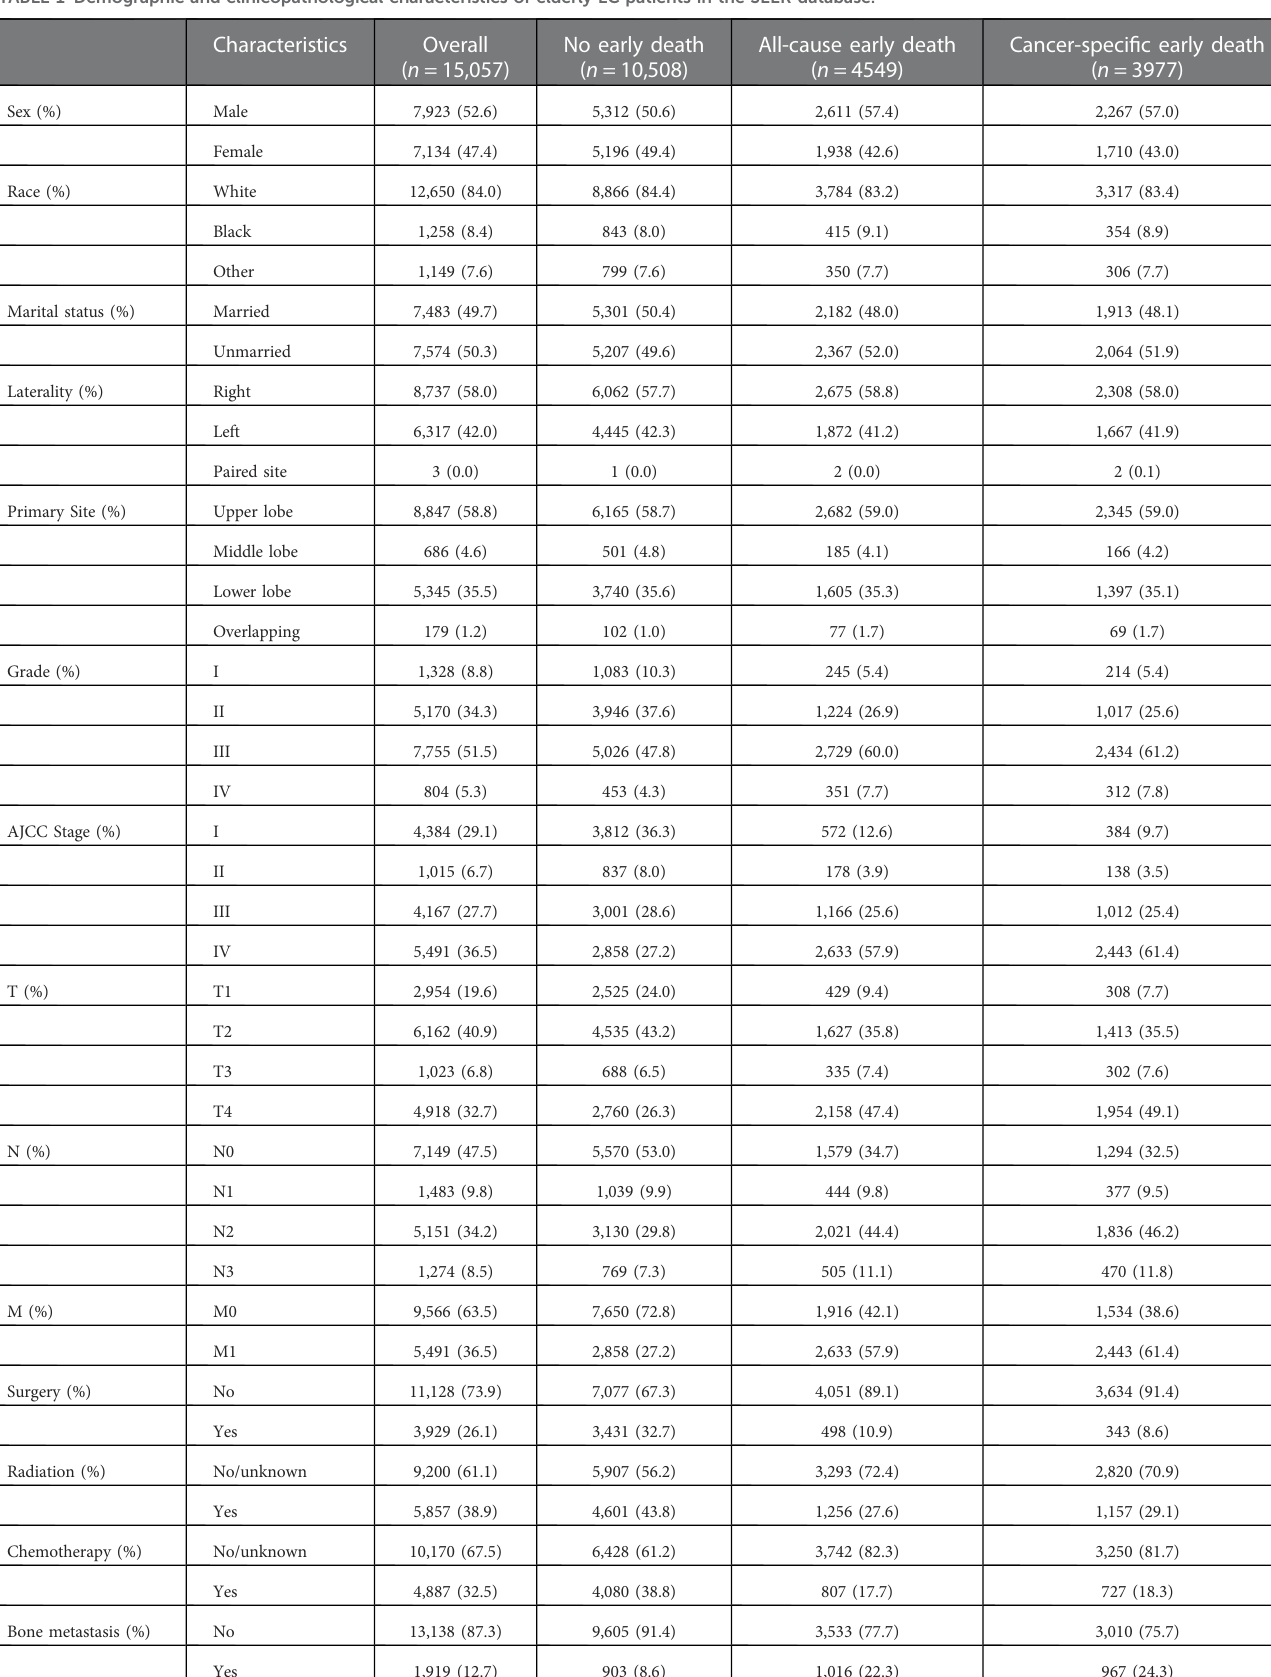
TABLE 1 Demographic and clinicopathological characteristics of elderly LC patients in the SEER